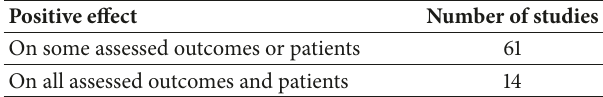
Table 13: Health status of participants in included studies.